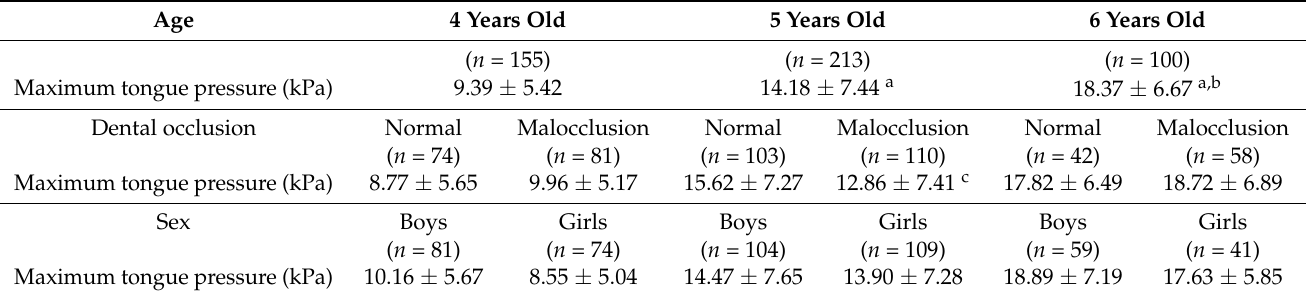
Table 2. Maximum tongue pressure in children aged 4–6 years.